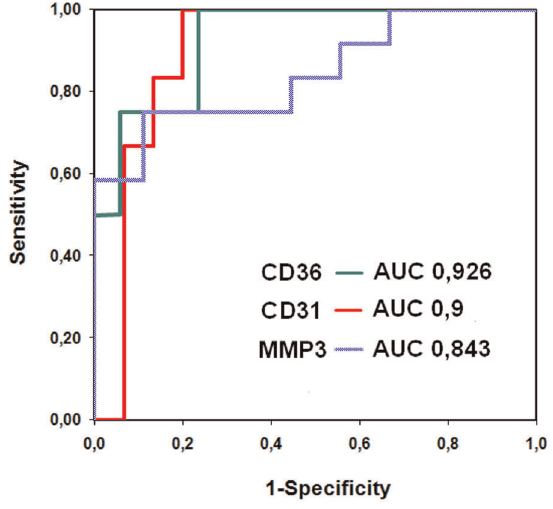
Figure 5. ROC curves computed by determined impedance values ( at 100 kHz ) . ROC curves separating samples of abundant and minor/no staining with good (MMP-3) to excellent (CD31, CD36) accuracy.